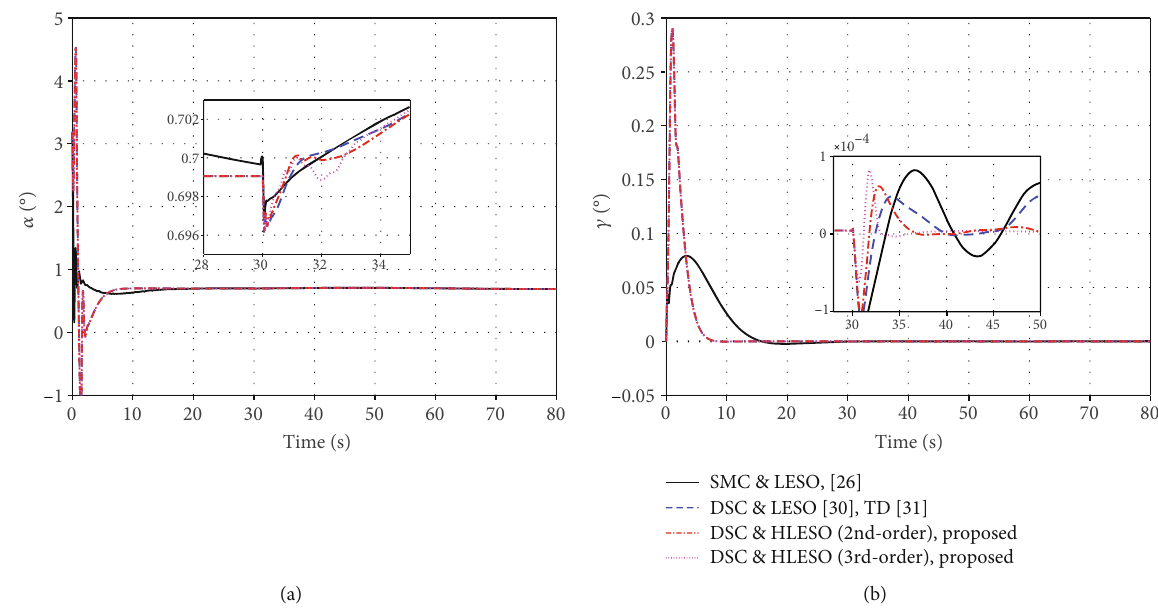
Figure 7: Parametric response curve: (a) attack angle and (b) track angle. Table 5: The tracking errors of composite